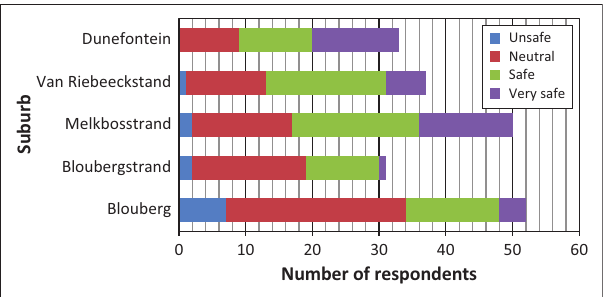
FIGURE 8: Respondents’ perception of the accessibility and availability of information related to general